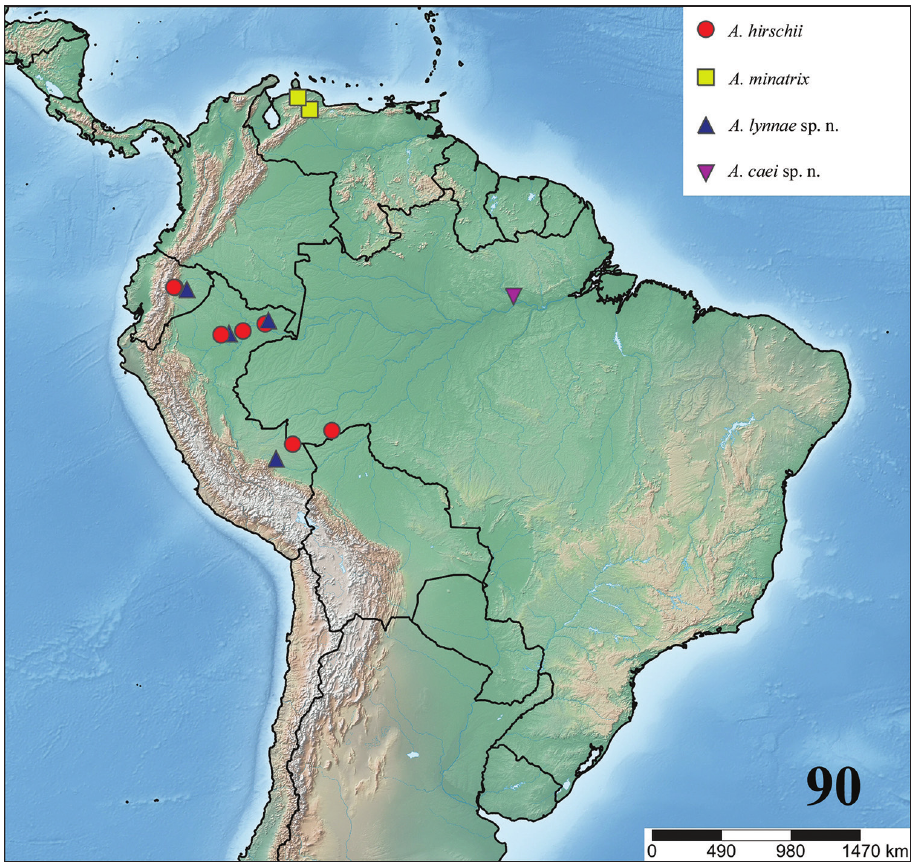
Figure 90. Map showing records of A. minatrix Pocock, 1903, A. hirschii Bullmer, Thierer-Lutz & Schmidt, 2006, A. lynnae sp. n. and A. caei sp.